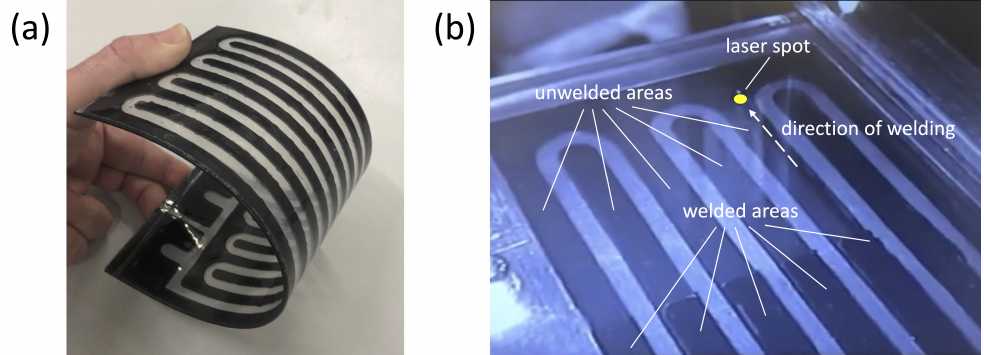
Figure 8. Flexible polypropylene pulsating heat pipe ( a ) and detail of the selective transmission laser welding process ( b